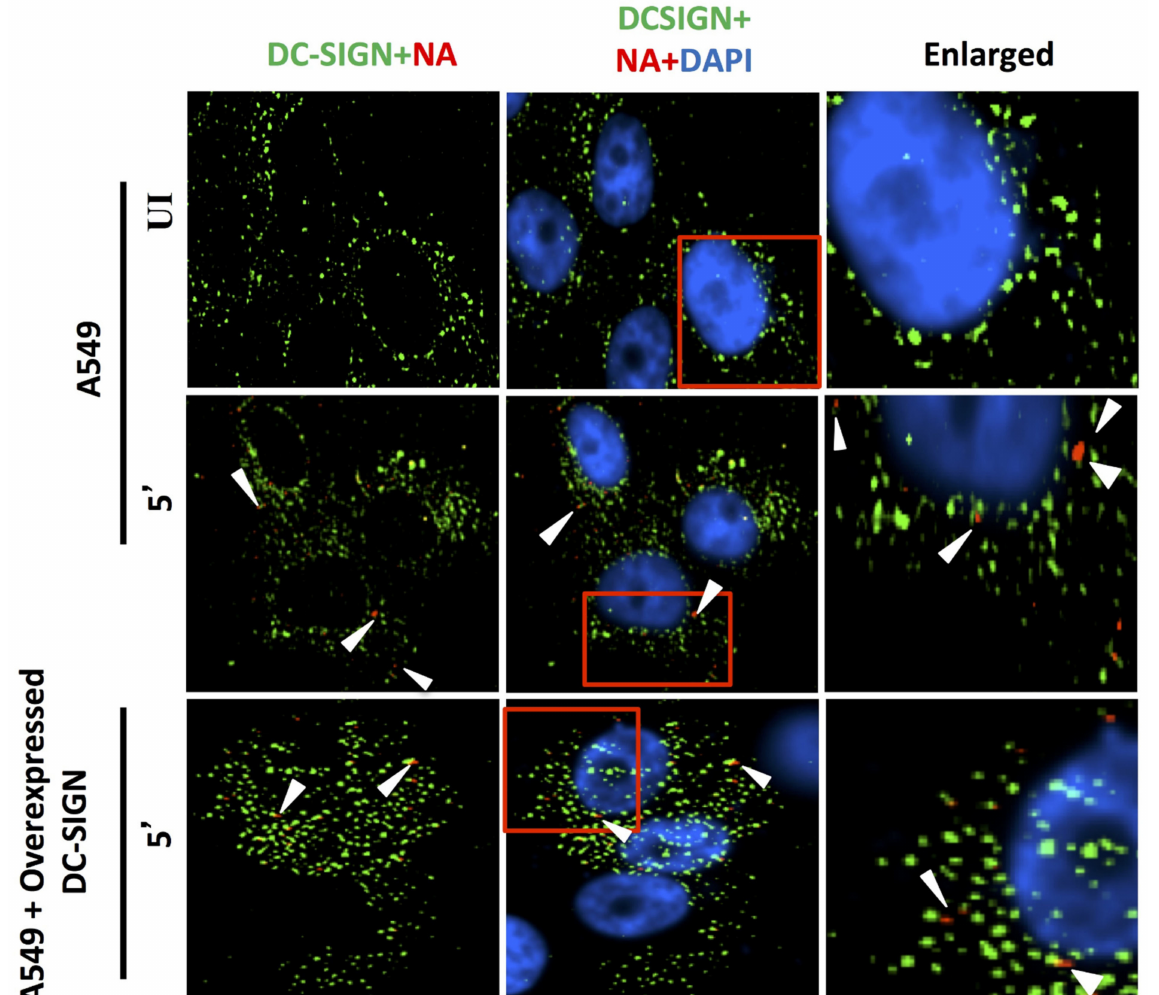
Figure 9. DC-SIGN (green) and influenza NA (red) after 5 min of virus binding. No trace of virus binding in uninfected cells (upper panel). Few co-localization spots (yellow spots, middle panel) in cells with endogenous level of DC-SIGN; in cells overexpressing DC-SIGN (green) there is no consequent increase in virus binding (bottom panel, white arrow) as compared to cells with endogenous level of DC-SIGN (middle panel, white arrow). Altogether, virus binding is not significantly increased with overexpression of